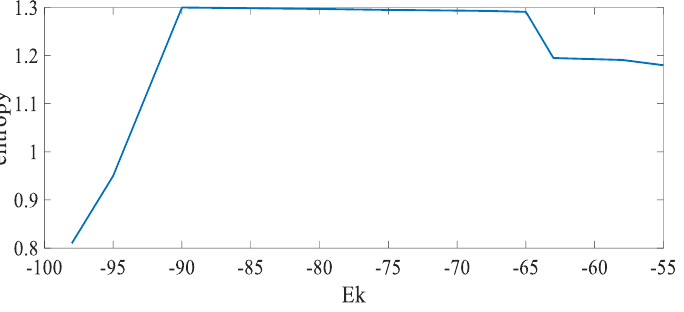
Figure 4. Changing E n by the variation in E k .